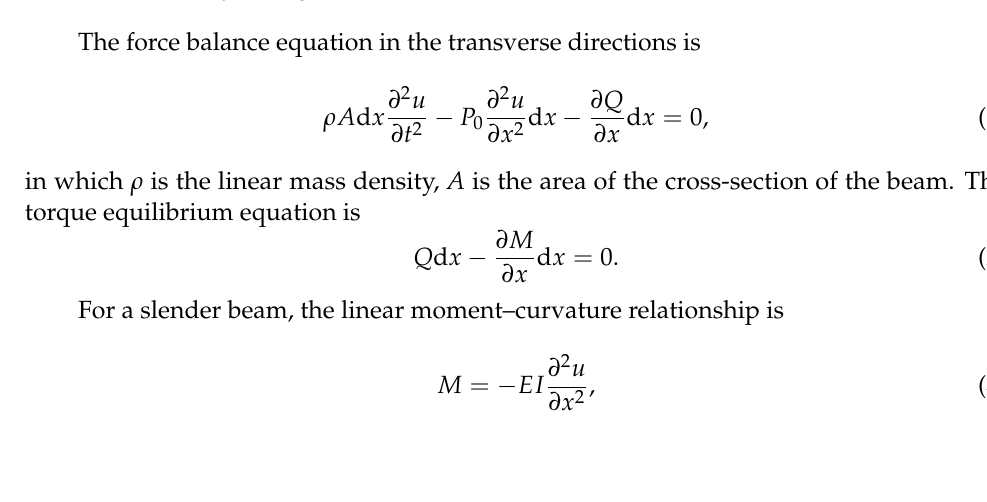
Figure 1. Force analysis diagram of